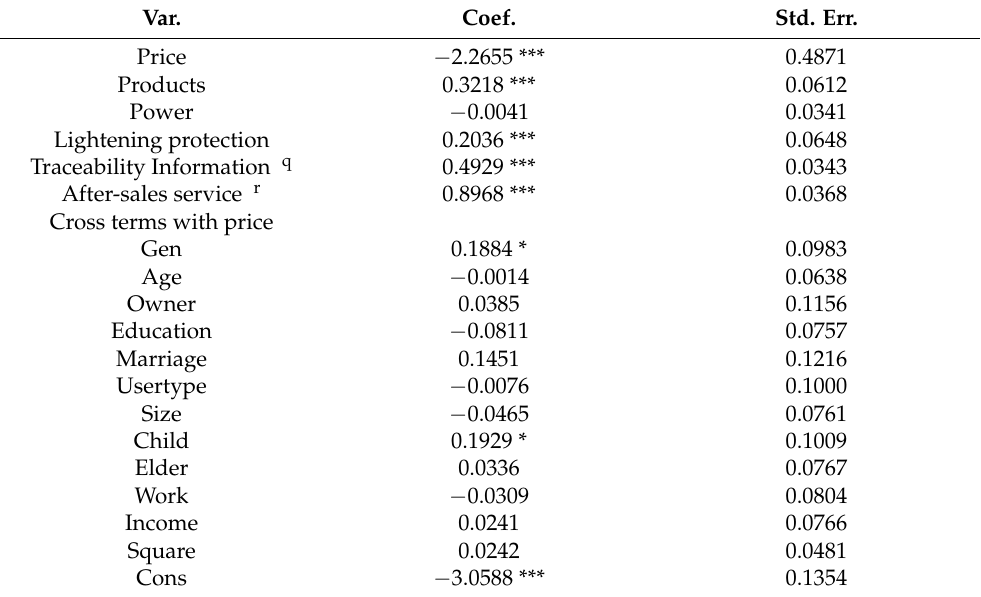
Table 7. Regression